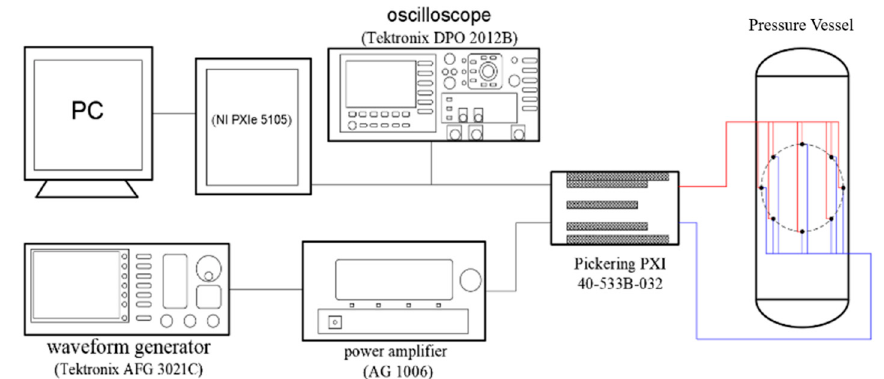
Figure 5. Experimental